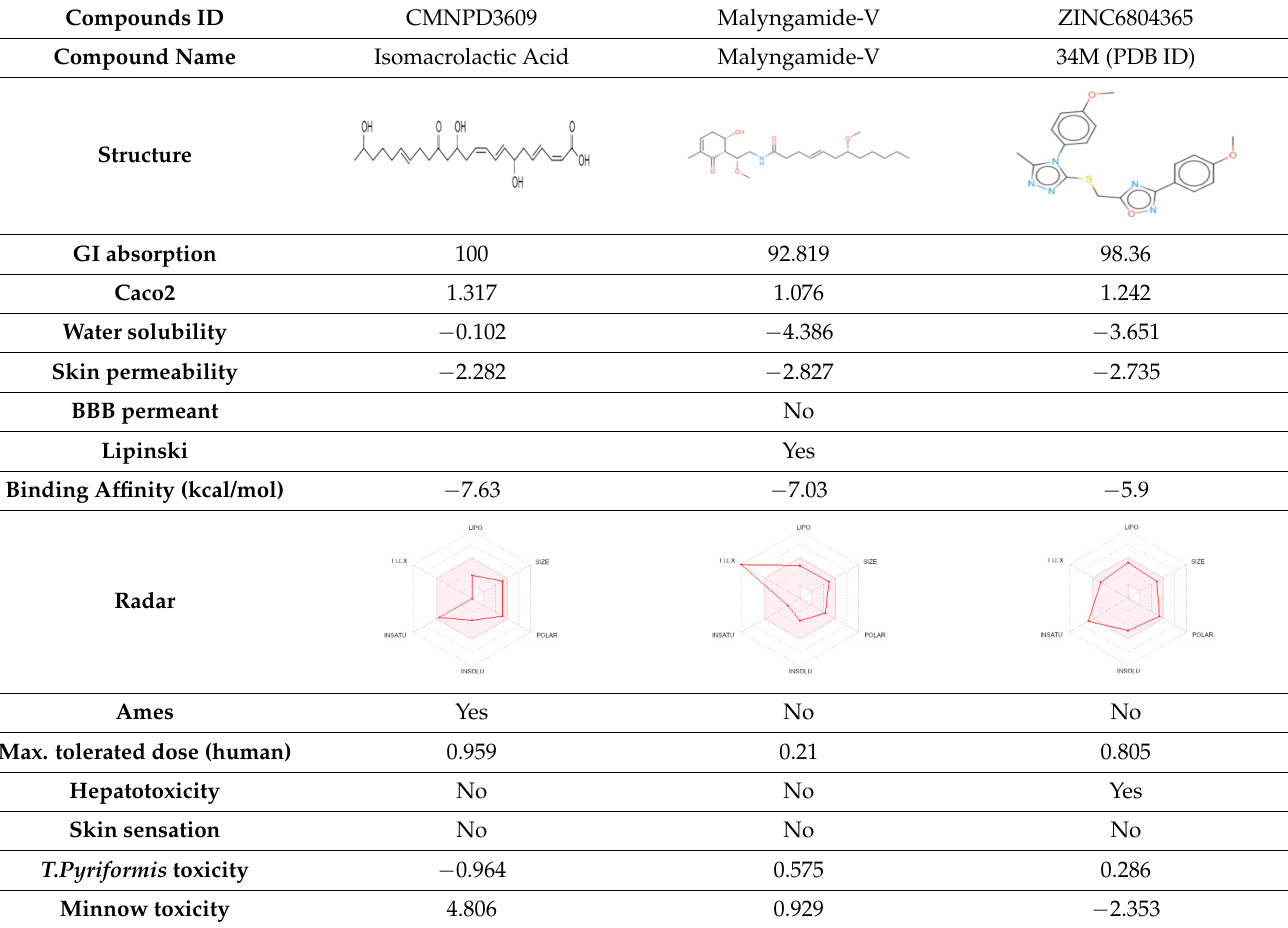
Table 3. Three shortlisted compounds as possible drug candidates against RiS along with their ADMET